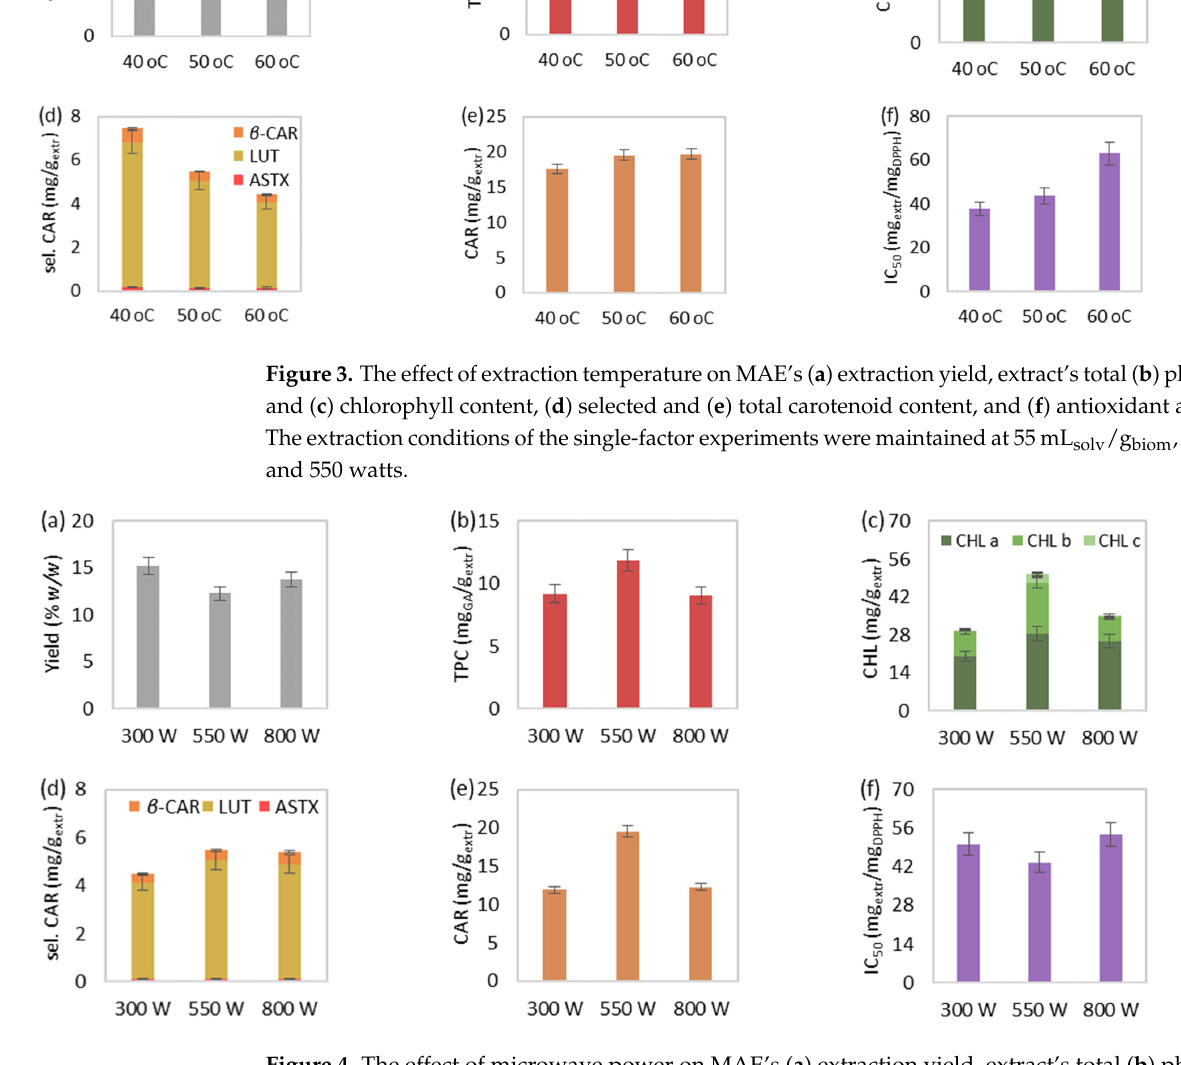
Figure 4. The effect of microwave power on MAE’s ( a ) extraction yield, extract’s total ( b ) phenolic and ( c ) chlorophyll content, ( d ) selected and ( e ) total carotenoid content, and ( f ) antioxidant activity. The extraction conditions of the single ‐ factor experiments were maintained at 50 °C, 55 mL solv /g biom and 15 min.